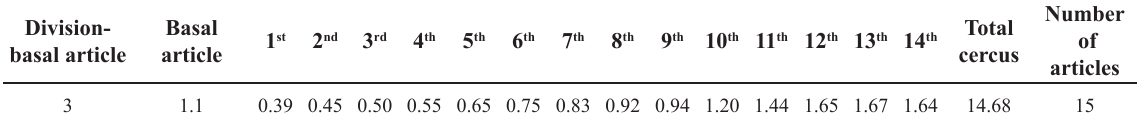
Table 2. Anisuracampa ywangana Sendra & Komerički sp. nov., paratype MZB (MCNB) 2020-1153, length of cercal articles and total length (units in mm), including number of articles of the cercus, basal article included, and division of basal article in secondary